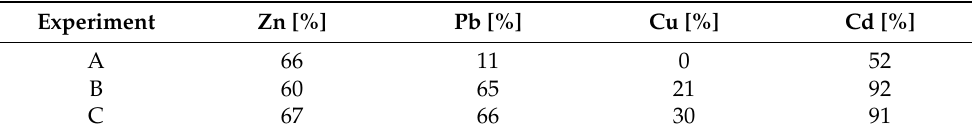
Table 5. Mean recoveries of Zn, Pb, Cu and Cd of the industrial-scale experiments of the FLUWA process within one day at MSWI plant Linth.